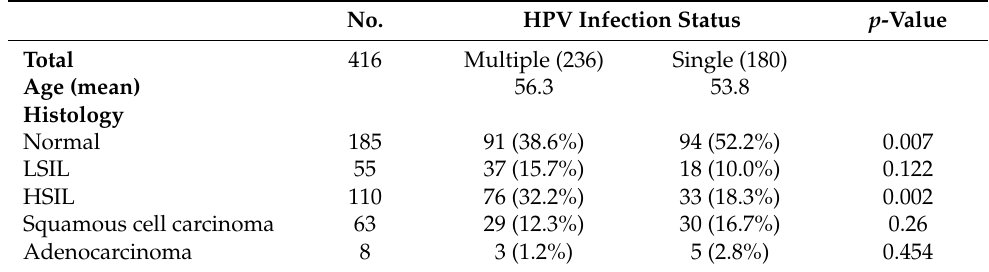
Table 2. Correlation between histologic diagnosis and HPV infection status (single and multiple).